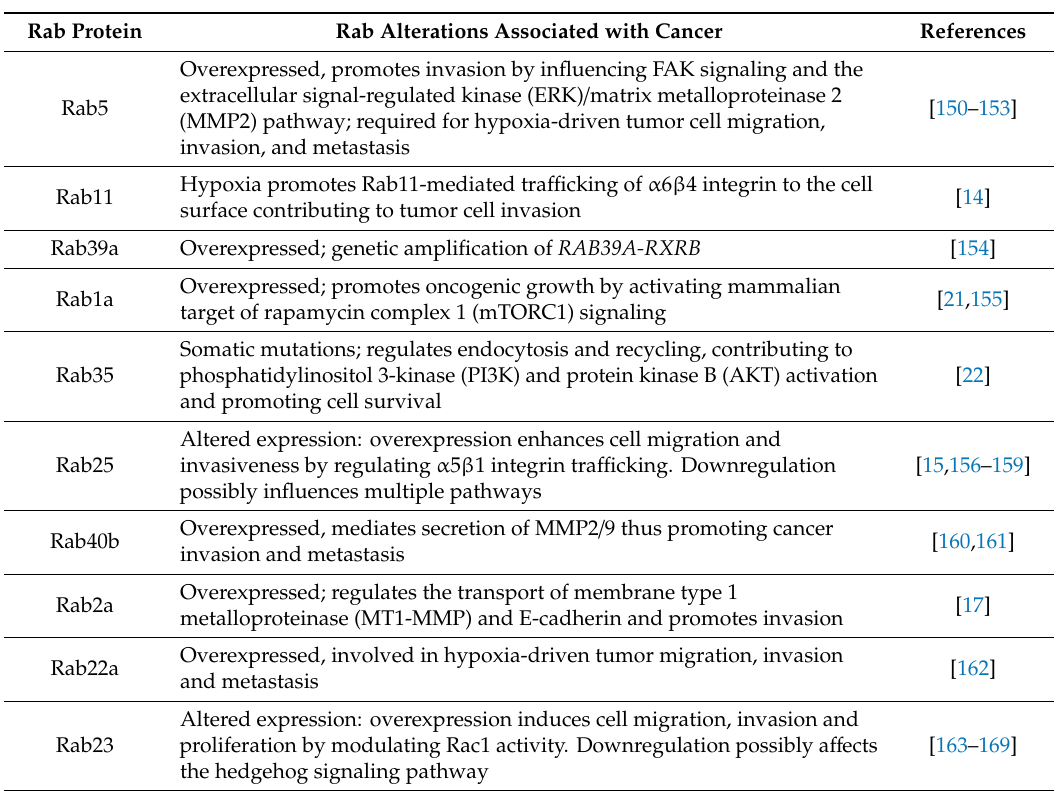
Figure 2. Rab proteins in cancer. Model representing a cancer cell invading the extracellular matrix (ECM) by using invadopodia, which are actin-rich structures. The illustration shows the main transport and signaling pathways affected by altered Rab protein expression in cancer. MMP: matrix metalloproteinase, FAK: focal adhesion kinase, Shh: Sonic hedgehog; PI3K: phosphatidylinositol 3-kinase; AKT: protein kinase B; mTORC1: mammalian target of rapamycin complex 1. Table 2. Rab proteins involved in cancer.